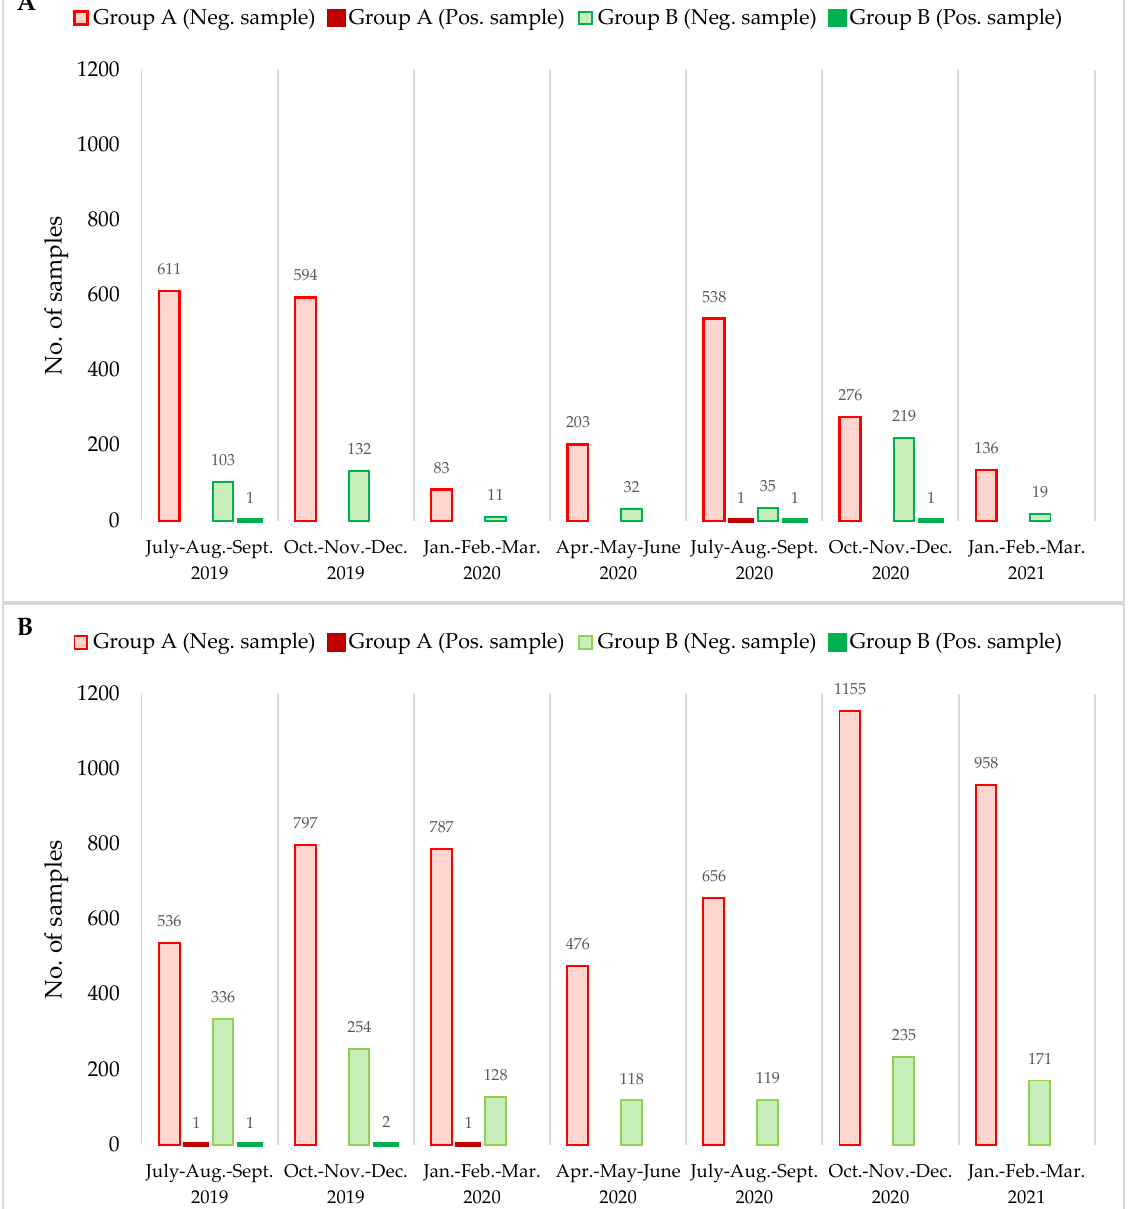
Table 4. Salmonella spp. in ready-to-eat food, from July 2019 to March 2021.